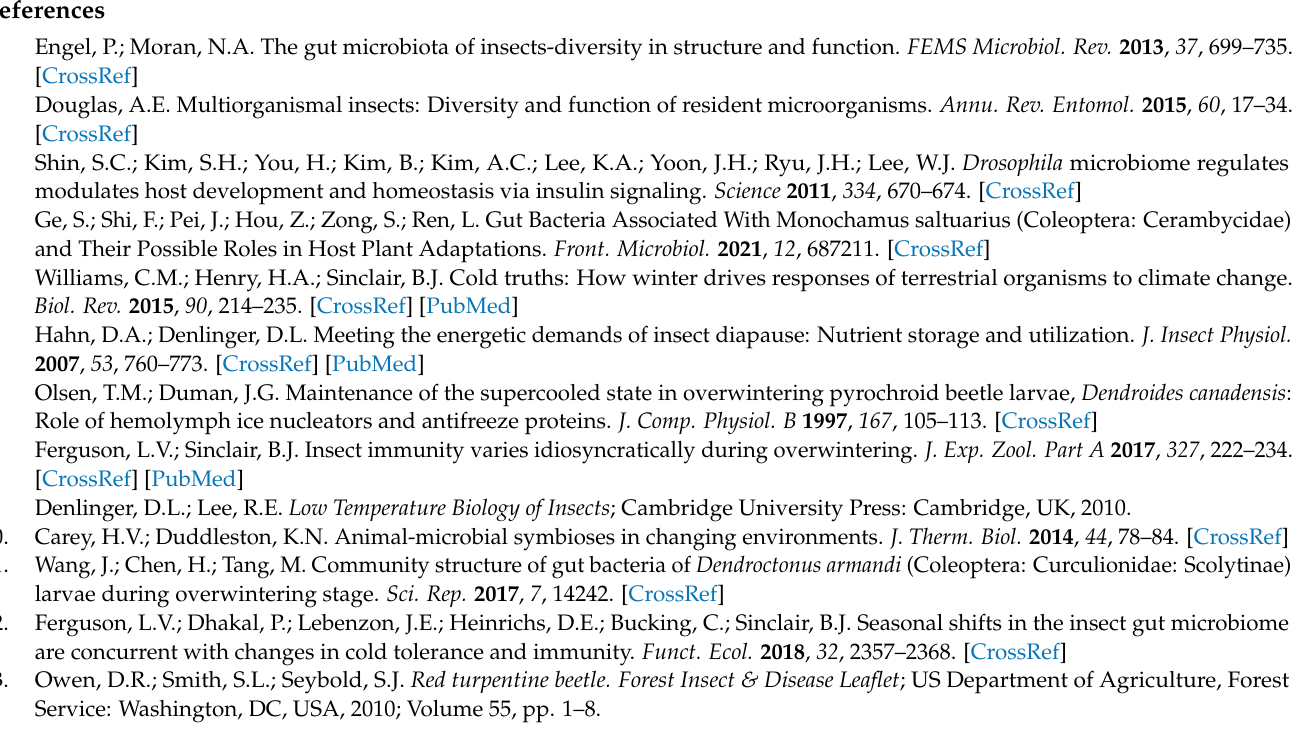
Figure S2: Rarefaction plots for fungal microbiomes in the gut of D . valens across seasons, Table S1: Summary of sequence number and operational taxonomic units (OTUs) in the gut microbiome of D . valens